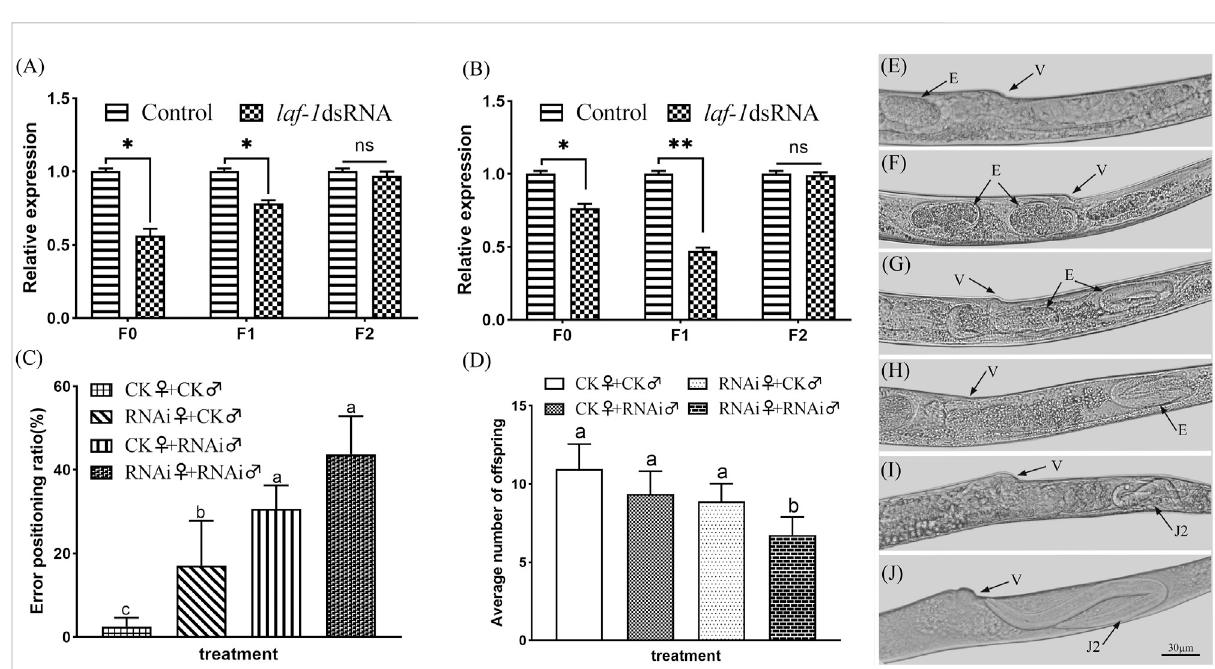
FIGURE 8 RNAi soaking by Bxy-laf-1 . Real-time quantitative PCR analysis of Bxy-laf-1 expression levels after RNAi soaking at embryos (A) and J2 (B) . Asterisks indicate a signi fi cant difference between two groups (*means p < 0.05, **means p < 0.01). (C) Error positioning ratio of B. xylophilus virgin adults. (D) Average number of offspring of B. xylophilus . The same letter indicates that the difference is not signi fi cant, and different letters indicate that the difference has reached a signi fi cant level between two groups ( p < 0.05). (E,F) Position of embryos in the control group in vivo . (G,H) Embryosthathavemovedtothetailafter Bxy-laf-1 dsRNAtreatment. (I,J) J2larvaethathavehatchedinthetail.Errorbarsrepresentstandarderrorof mean. v, vulva; E, embryo; J2, second-stage juveniles. Scale bar: 30 μ m (E – J)